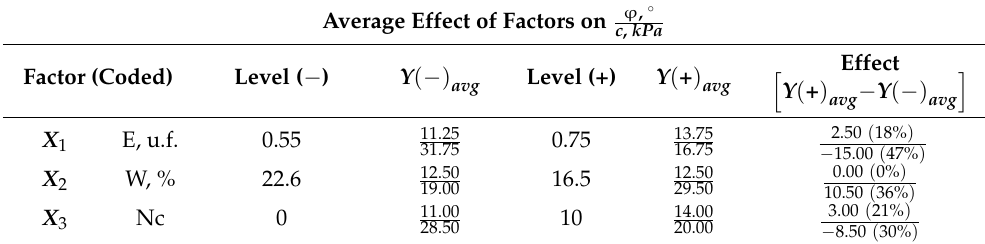
Table 4. Average effect of factors X 1 , X 2 , and X 3 on the strength characteristics of